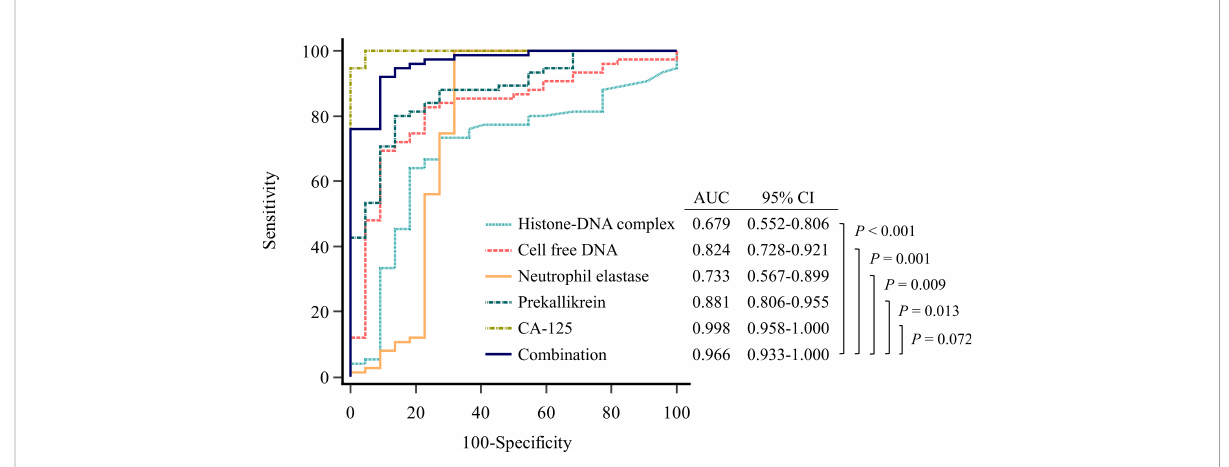
FIGURE 1 Evaluation of diagnostic performance of the markers for detecting ovarian cancer using receiver operating characteristic curve analysis. Combination marker indicates a logistic regression-based model of histone − DNA complex, cell-free DNA, neutrophil elastase, and